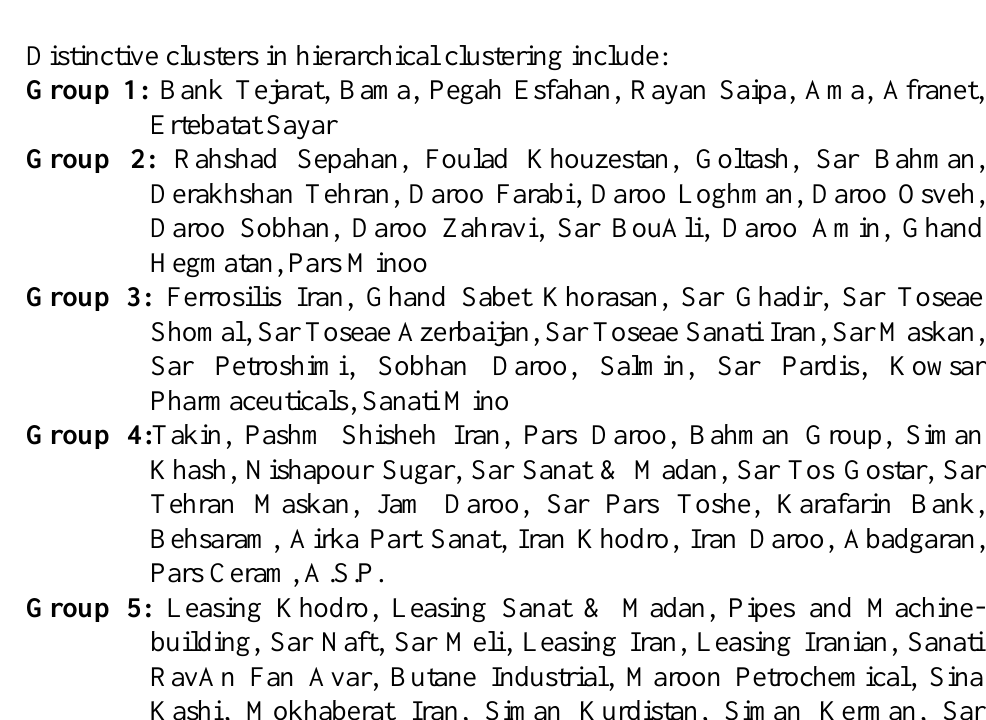
Figure 2. Hierarchical clustering based on behavioral